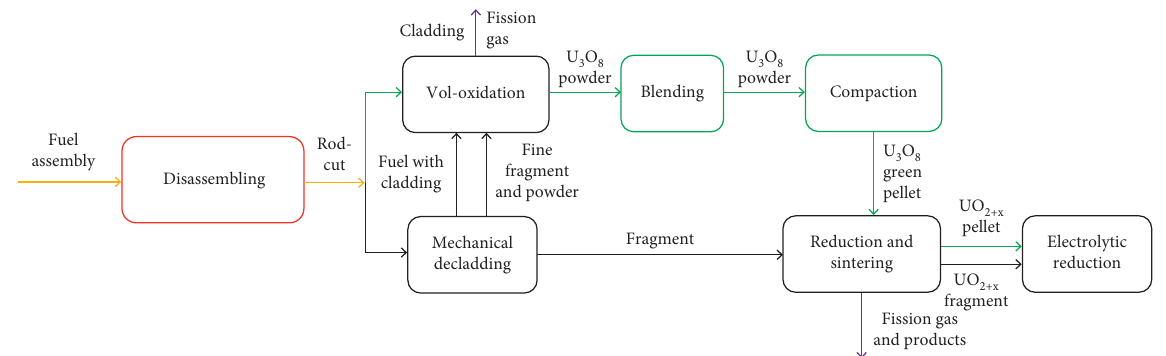
Figure 1: Flowchart for the dry head-end Table 1: Comparison of the disassembling technology in the head-end processing.